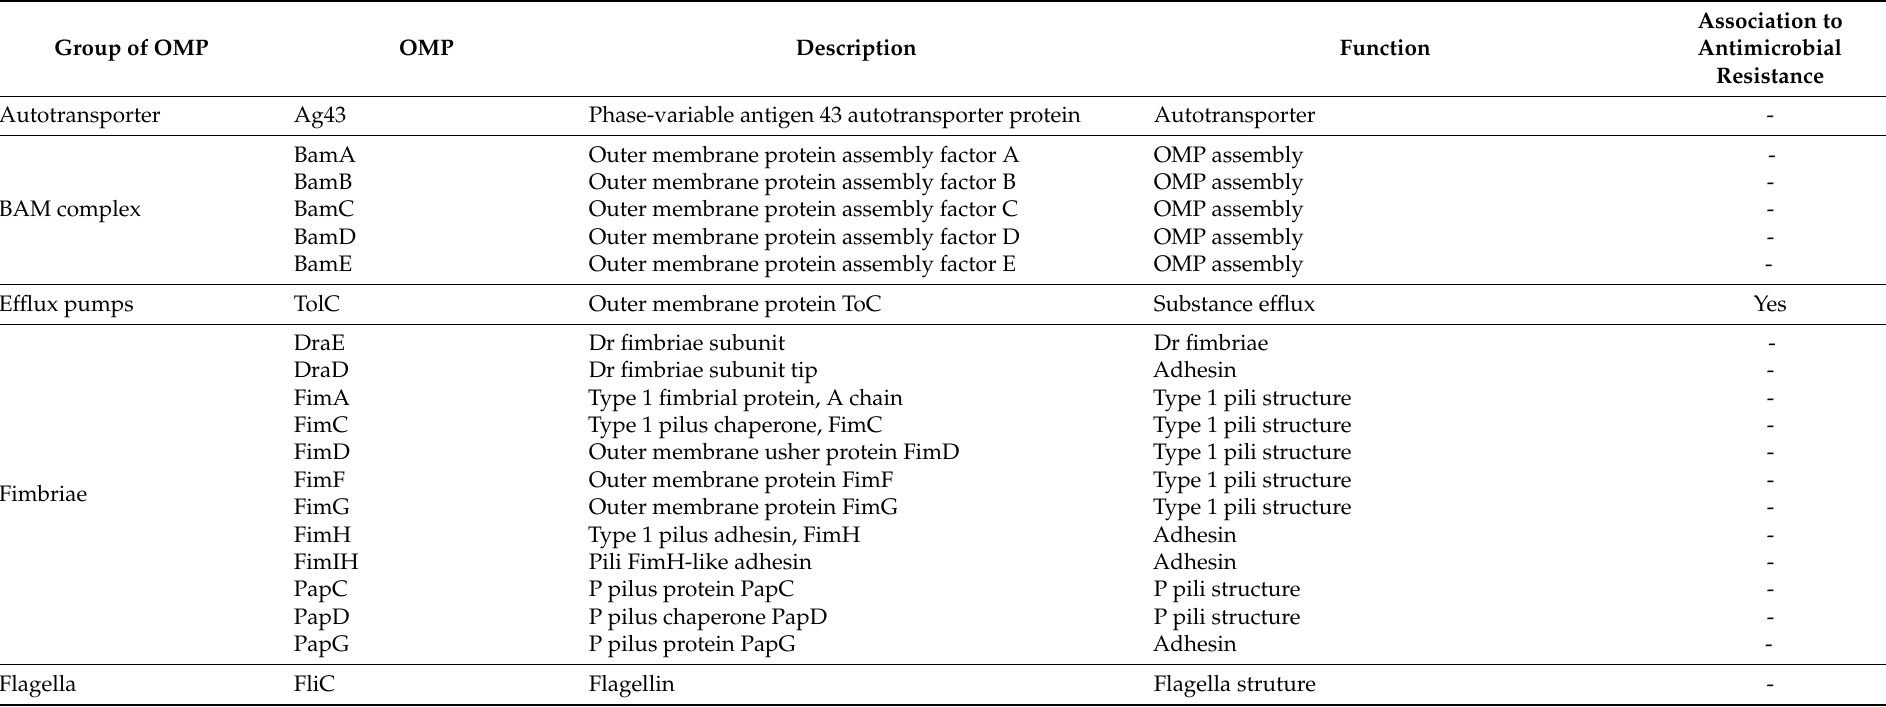
Table 2. Overview of UPEC OMPs and their association to antimicrobial resistance. Integrated view of results is described, listing the OMP found in UPEC’s outer membrane as well as their